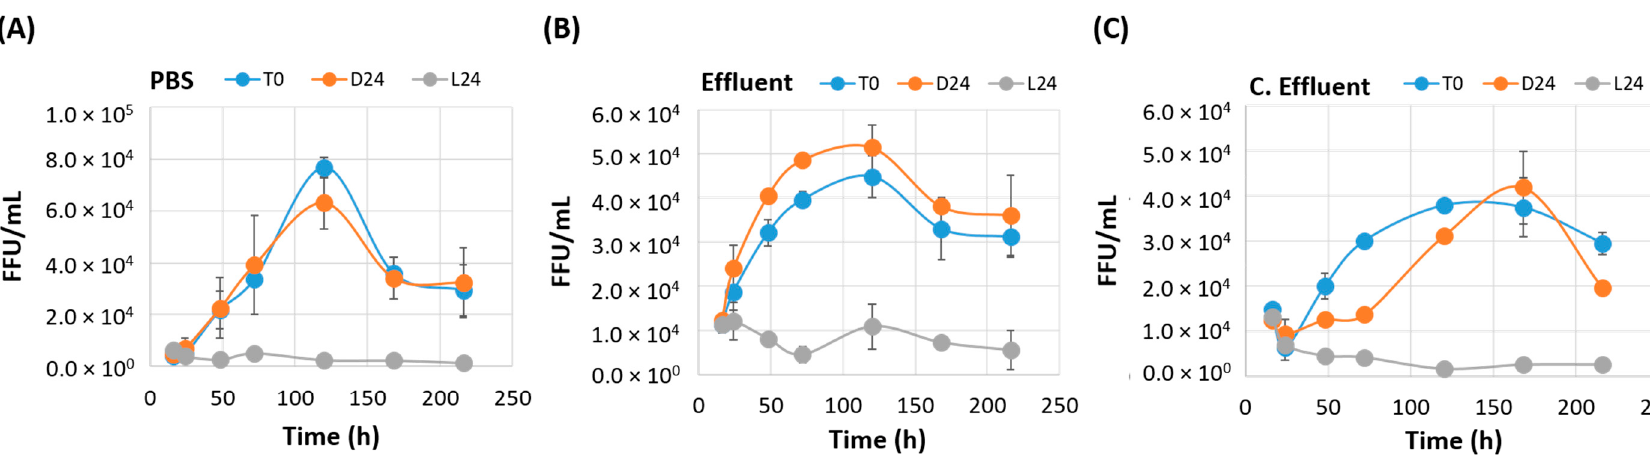
Figure 2. Growth kinetics of nontreated EV70 (T0 ● ), dark-control EV70 (D24 ● ), and simulated-solar-irradiated EV70 (L24 ● ). Confluent monolayers were infected with similar concentrations of each of the viral samples, and the foci formed over a nine-day period were enumerated. ( A ) EV70 resuspended in phosphate-buffered saline (PBS) (n = 3). ( B ) EV70 resuspended in effluent wastewater matrix (n = 2). ( C ) EV70 resuspended in chlorinated effluent wastewater matrix (n = 2).